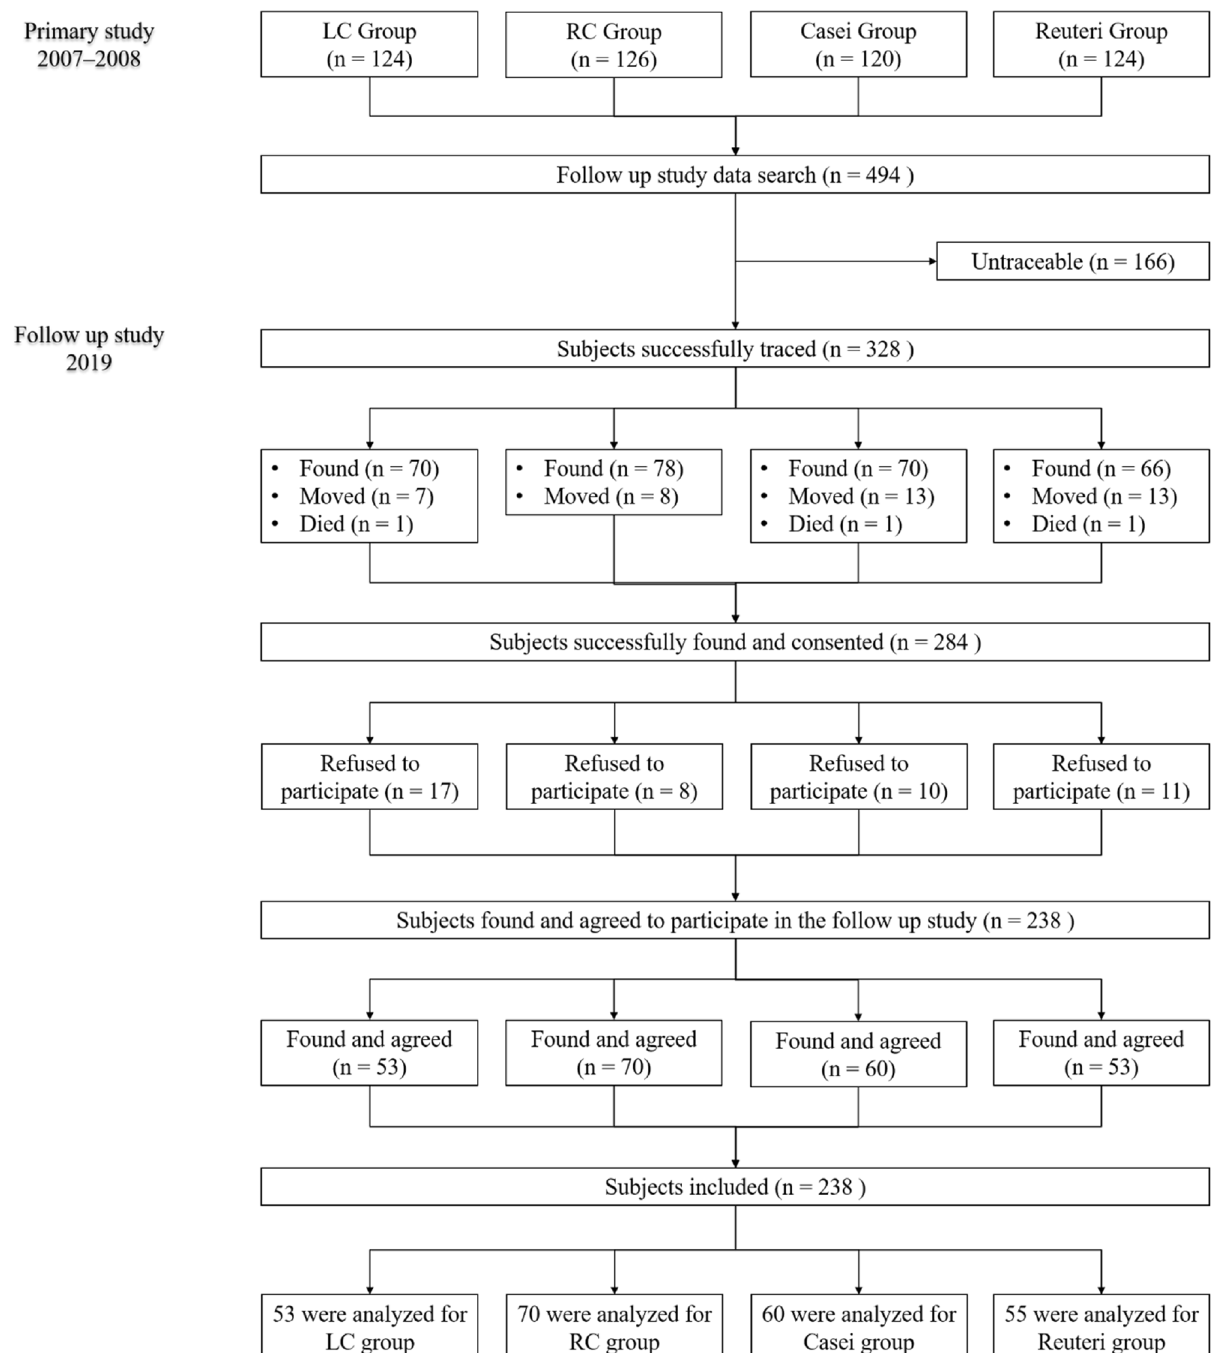
Figure 1. Flow diagram of follow-up study. Modified from Pediatrics.